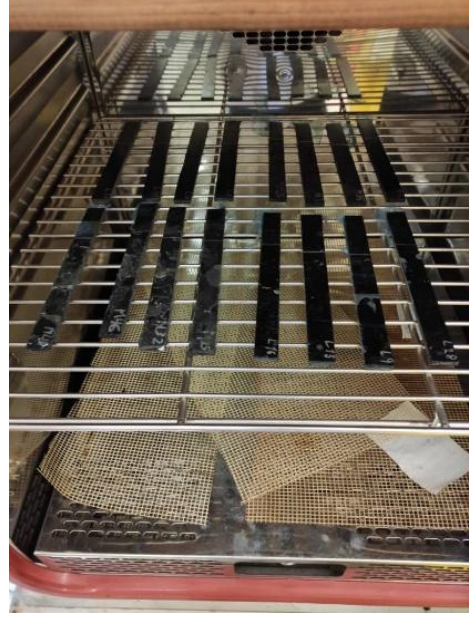
Figure 2. Aging of the samples in the chamber.